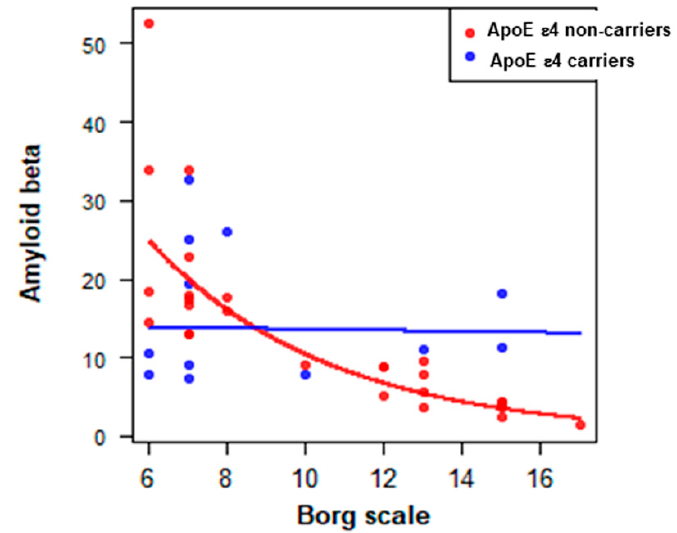
Figure 4. Multiple linear regression analysis in ε 4-non carriers and ε 4 carriers. The analysis was used to assess the relationship between erythrocytes A β concentration and physical activity level in ε 4 carriers and non- ε 4 carriers.